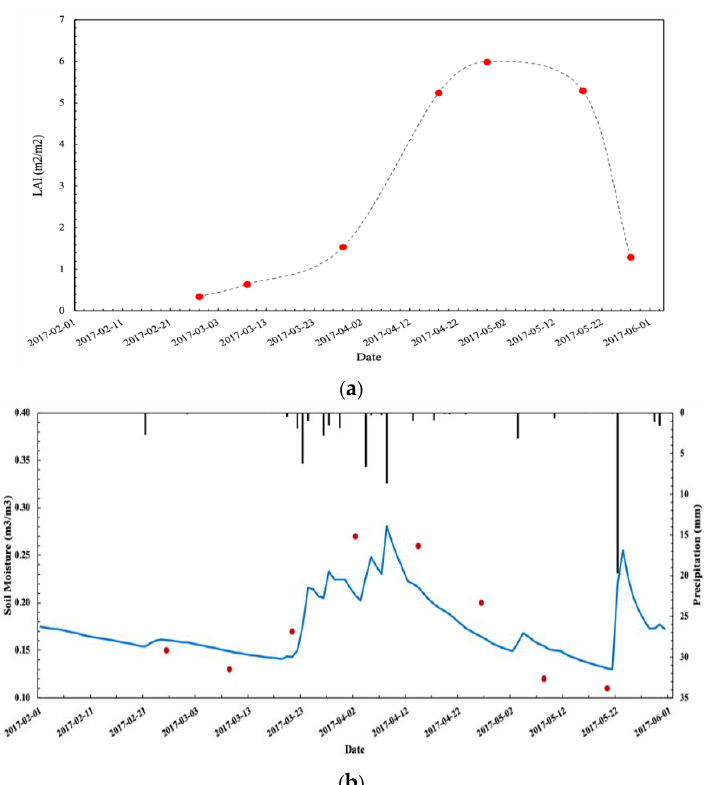
Figure 2. Temporal variations in retrieved leaf area index (LAI) ( a ) from Sentinel-2 and retrieved soil moisture (SM) ( b ) from Sentinel-1 at the Raoyang site. Temporal variation in S2 retrieved LAI (red dot) at the Raoyang site. Temporal variation in S1 retrieved SM (red dot) and in situ measurements at the Raoyang site.